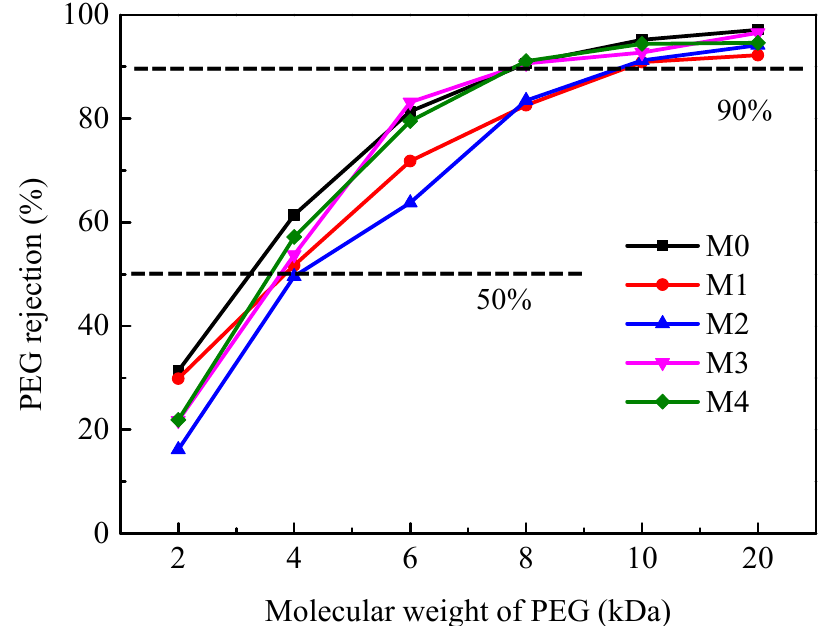
Figure 7. Water contact angle values ( a ) and the stress–strain behaviors ( b ) of PES and PES/MoS 2 membranes.